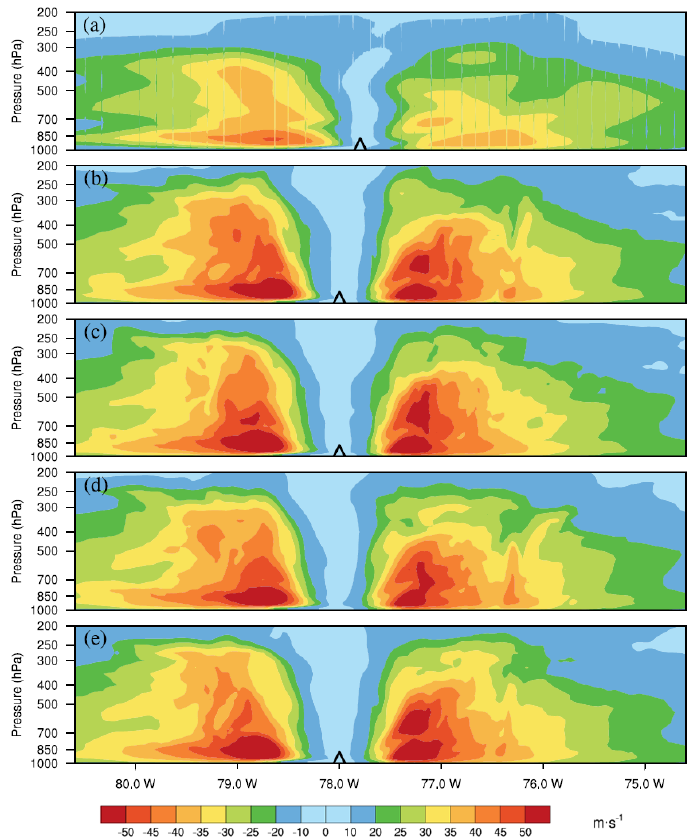
Figure 5. Wind field of vertical cross-section for Florence (at 1200 UTC on 14 September 2018) and Michael (at 1800 UTC on 10 October 2018) at landfall. Colored contours are wind speed (unit: m · s − 1 ). Panel ( a ) is the wind field of HRRR for Florence and Michael, and panels ( b – e ) are the forecast of Exp. FCO, Exp. FCOAS, Exp. FCOCY-2-50, and Exp. FCOASCY-2-50, respectively. The triangle represents the hurricane eye.